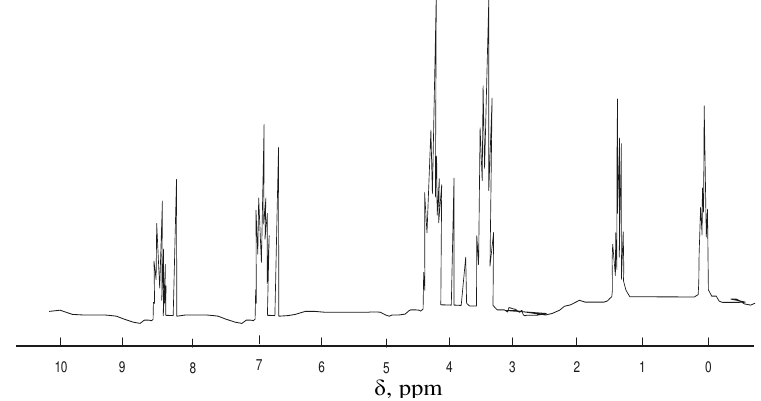
Figure 4 . 1H-NMR spectra of epoxidized